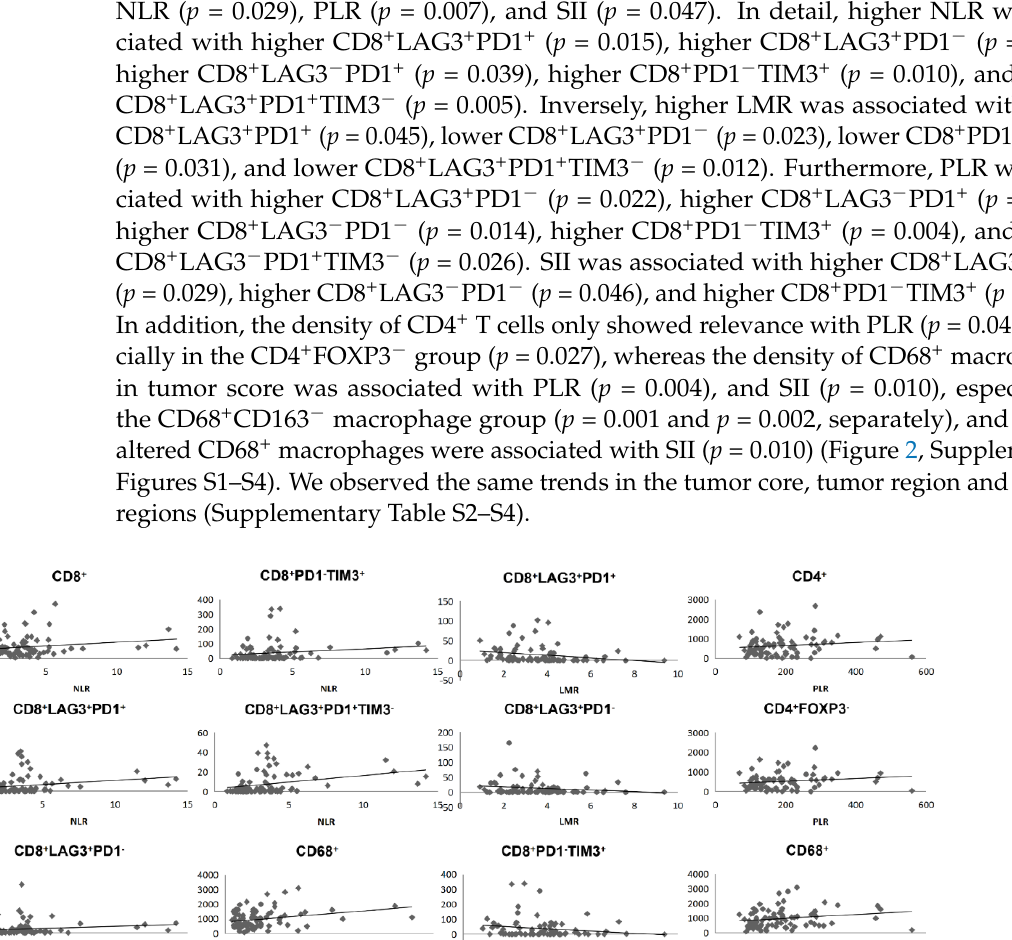
Table 2. Multivariate analysis of independent risk factors for disease progression. Variables